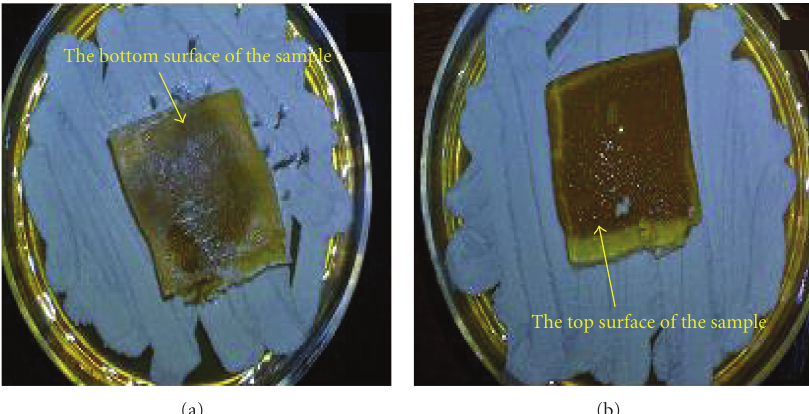
Figure 1: Hydrogel sample: (a) The bottom surface of the sample no growth was detected; (b) The top surface which showed the lack of full growth of fungi.